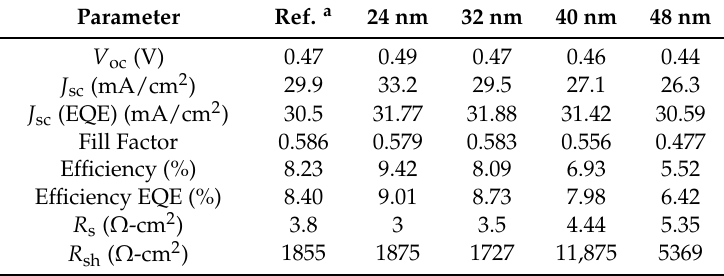
Table 1. Photovoltaic characteristics of TiO 2 /Si heterojunction solar